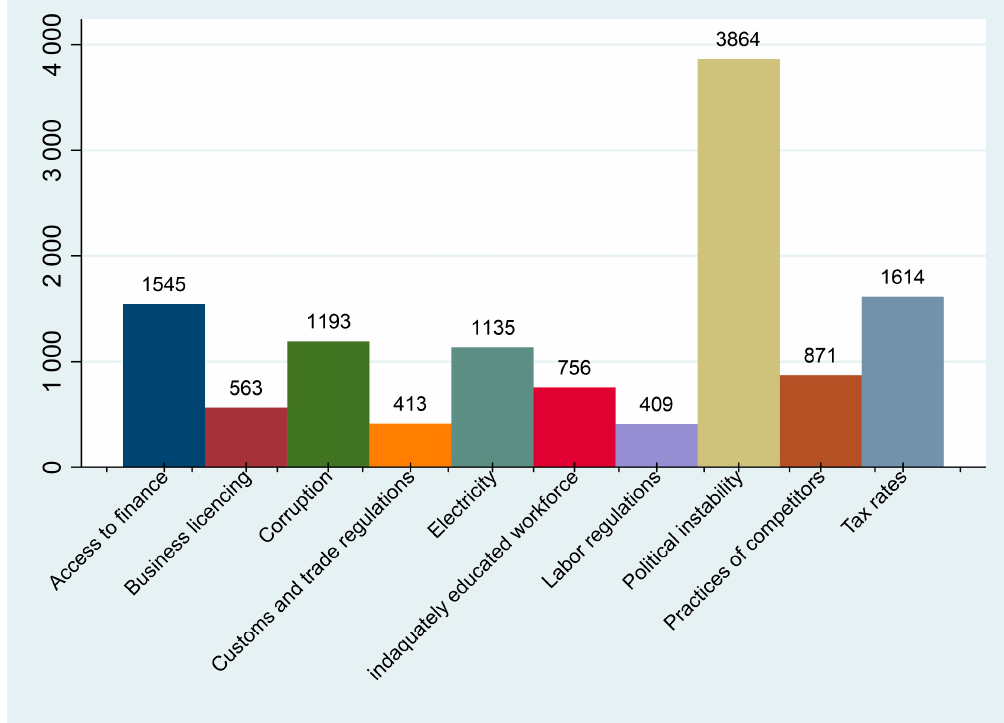
Figure 3. Major barriers for MENA firms. Source: author calculations WBES database (2020).